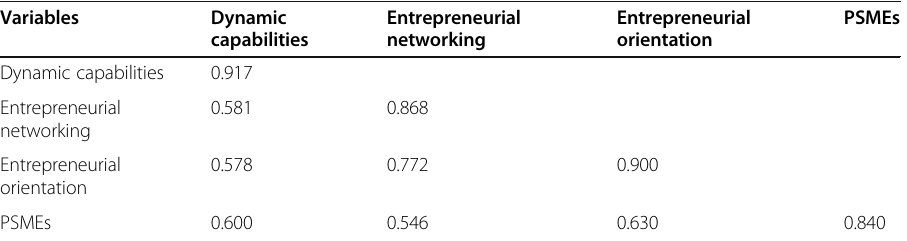
Table 3 Discriminant validity Variables